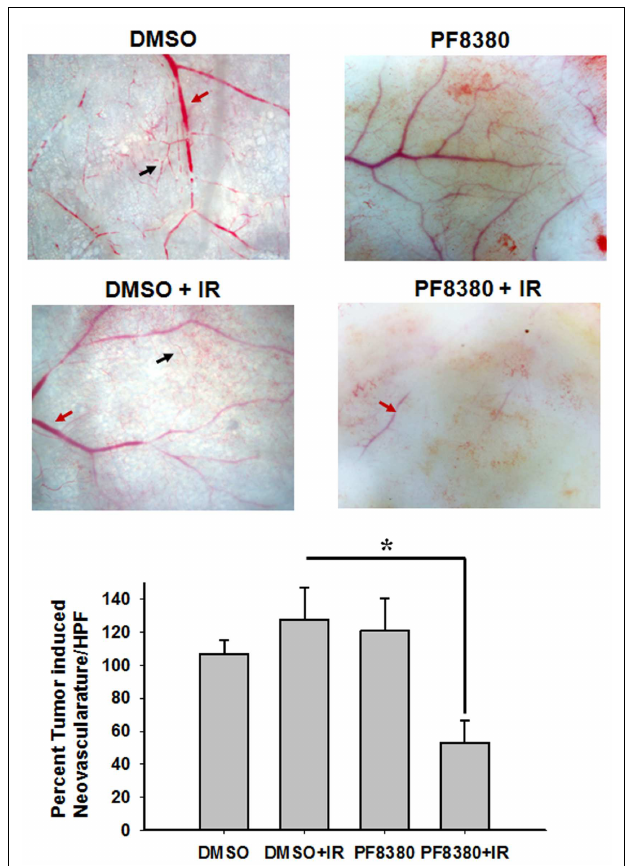
FIGURE 5 | Inhibition ofATX abrogates radiation induced tumor neovascularization .The animals were implanted with diffusion chambers containing GL261 cells. Seven days after implantation, the mice were treated with 10mg/Kg PF-8380 or DMSO for 30min prior to irradiation (3Gy). After 14days of implantation, the animals were sacrificed and the skin fold covering the diffusion chamber was observed. Shown are the representative micrographs showing the tumor induced neovasculature (black arrow) and preexisting vasculature (red arrow) and the bar graph depicting the mean number of neovasculature ( > 10 field for each mouse) SEM from each treatment group of five mice; * P < 0.05.